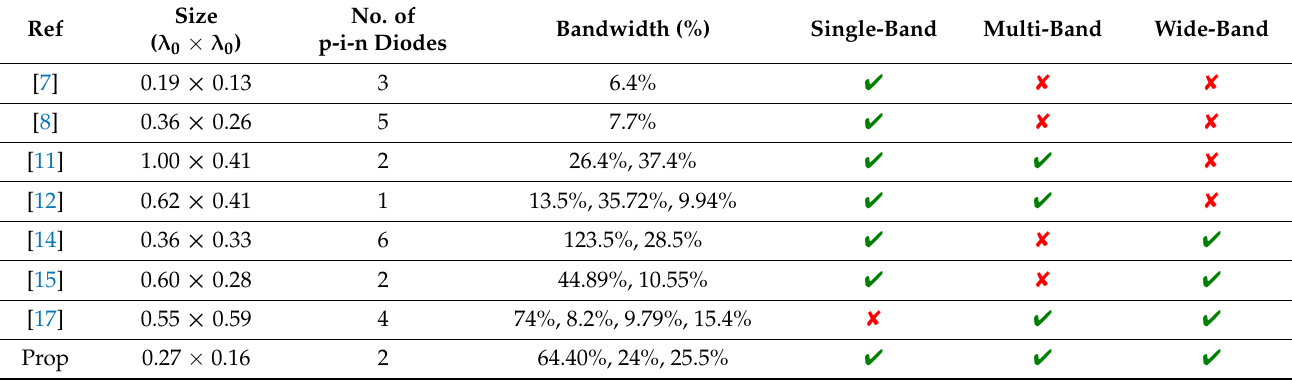
Table 1. Comparison with the state-of-the-art antennas. ( λ 0 is the wavelength at the lowest operating frequency.)